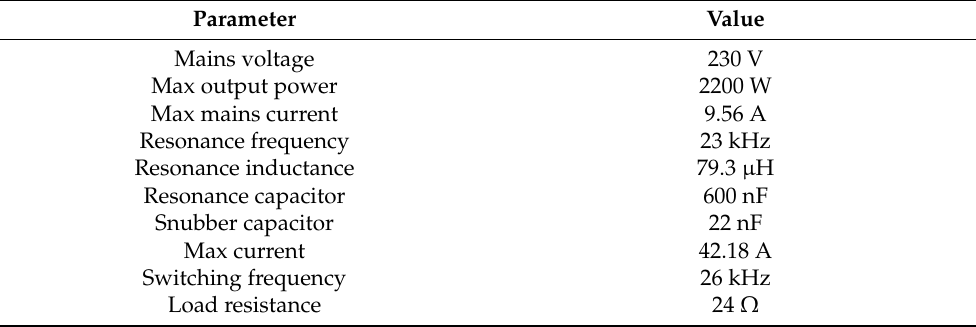
Table 4. Half-Bridge Series Resonant Converter Design